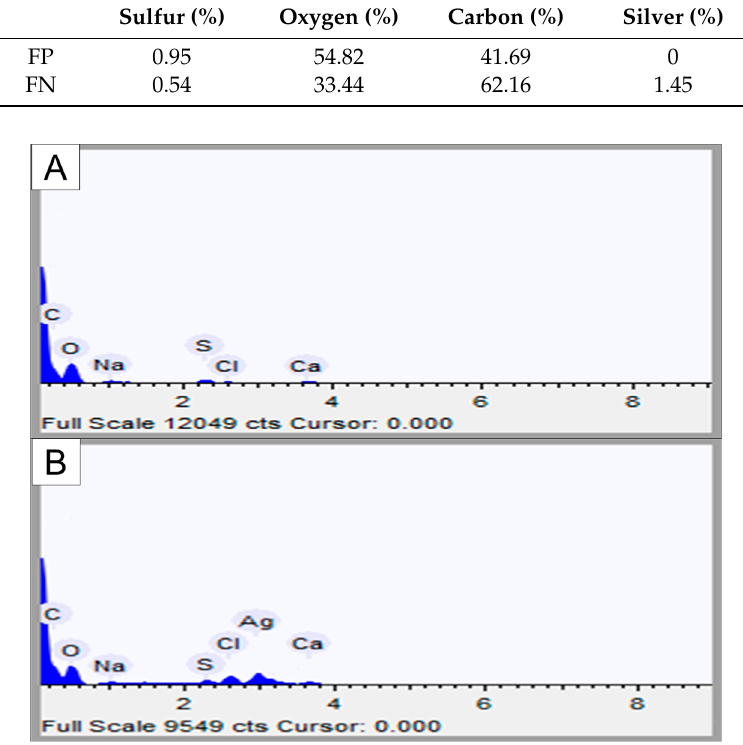
Table 2. Energy dispersive X-ray spectroscopy (EDS) of fucan polysaccharide (FP) and fucan-coated silver nanoparticles (FN).